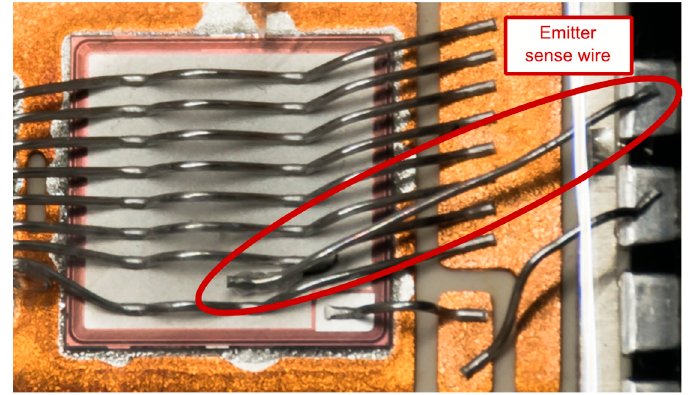
Figure 12. Photo of an IGBT chip in a power module with a dedicated pin and bond wire for emitter voltage sensing directly on the chip surface.